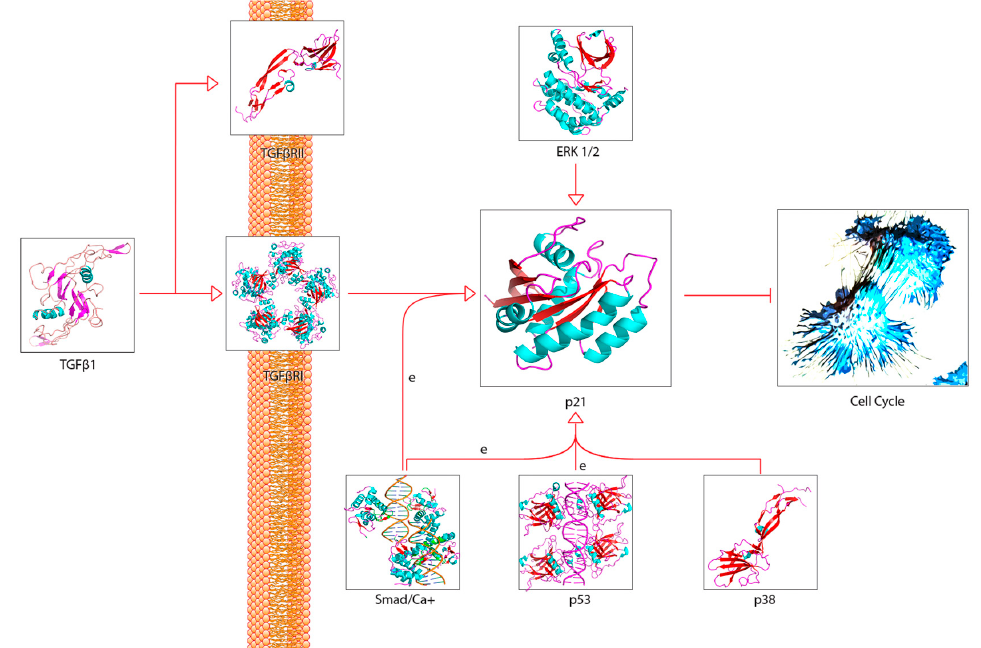
Figure 5. A simplified TGF β pathway leading to p21 expression. While p21 can be expressed through different pathways such as these, it is important to quantify which pathways affect p21 expression and activation the most in the RIBE response. This pathway is intrinsically connected to the TNF α , MAPK, and cell cycle pathways as an endpoint for intracellular signalling.